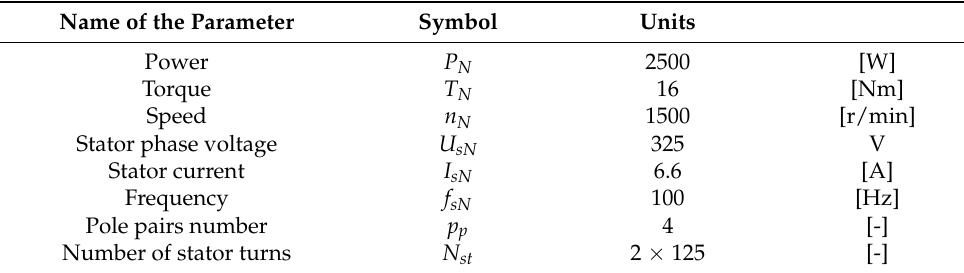
Table A1. Rated parameters of the tested